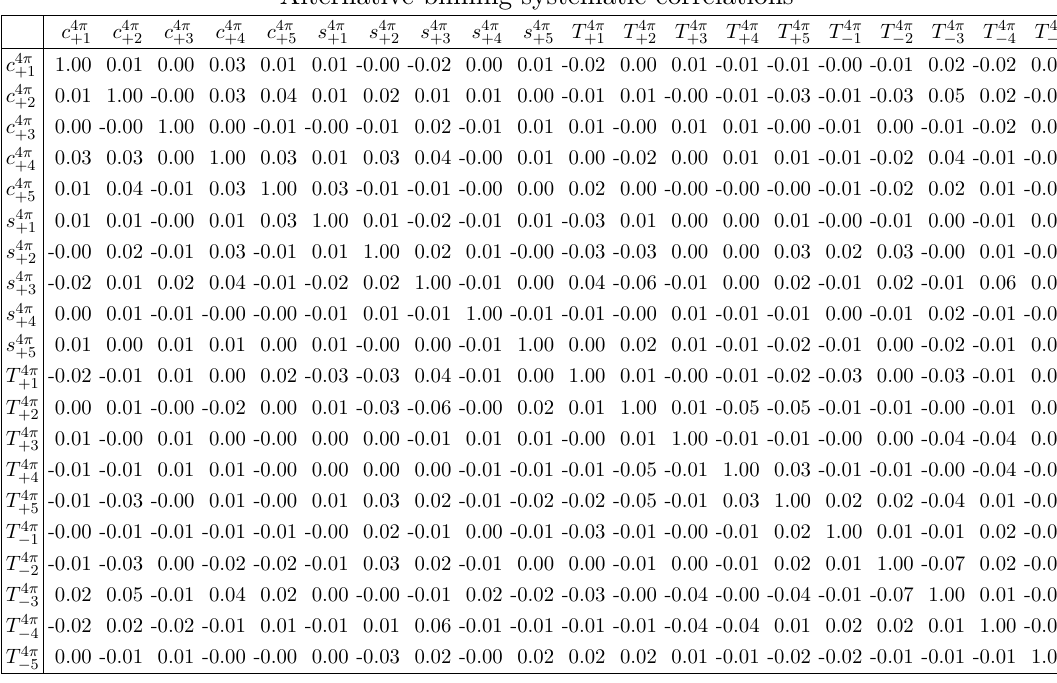
Table 11 . The statistical and systematic correlations between the 4 (cid:25) (cid:6) hadronic parameters using the Alternative binning scheme with N =